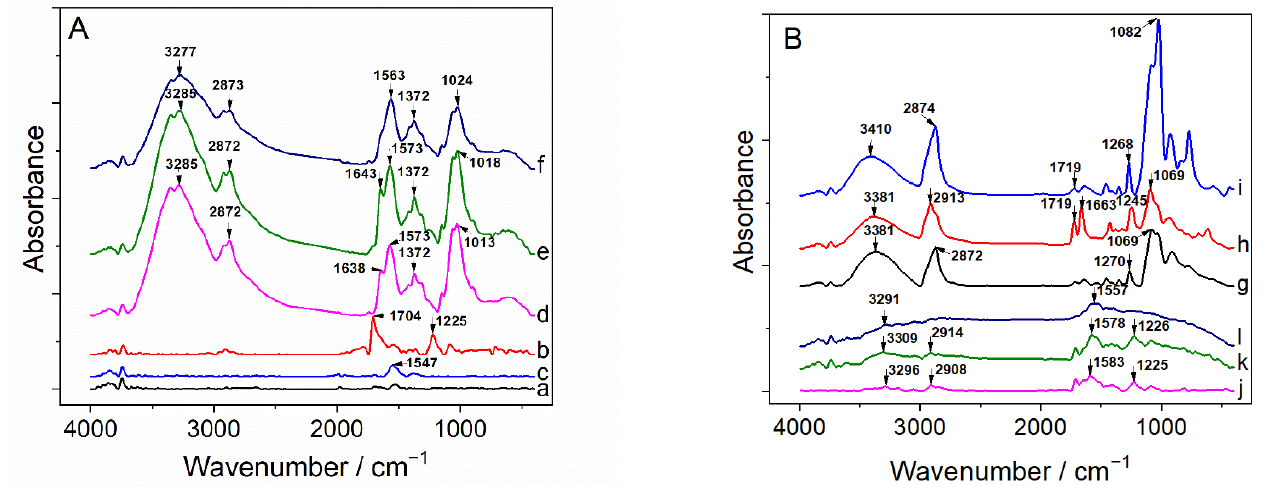
Figure 2. FTIR spectra for: ( A ) (a) SPE, (b) MWCNT/SPE, (c) MWCNT-AgNP/SPE, (d) CS/SPE, (e) MWCNT-CS/SPE, and (f) MWCNT-AgNP-CS/SPE. ( B ) (g) SG/SPE, (h) MWCNT-SG/SPE, (i) MWCNT-AgNP-SG/SPE, (j) 1,8-DAN/SPE, (k) MWCNT1,8-DAN/SPE, and (l) MWCNT-AgNP 1,8- DAN/SPE.